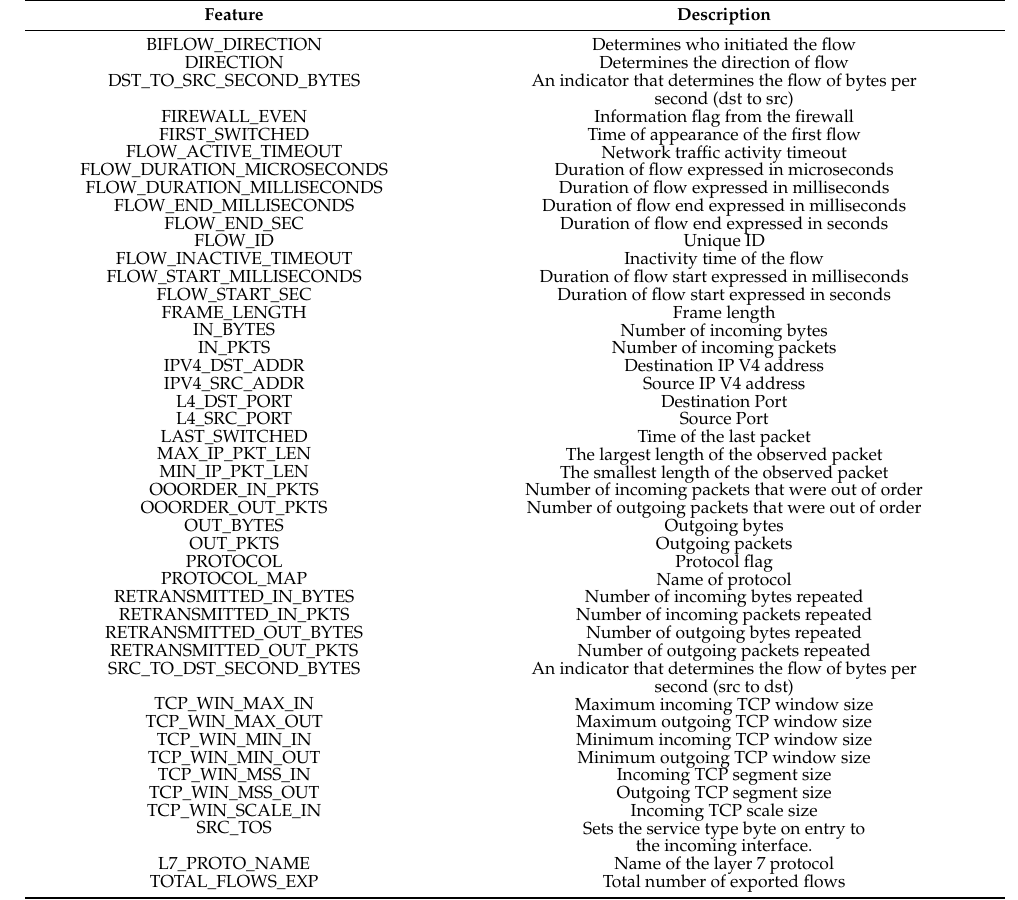
Table 6. The list of the collected network